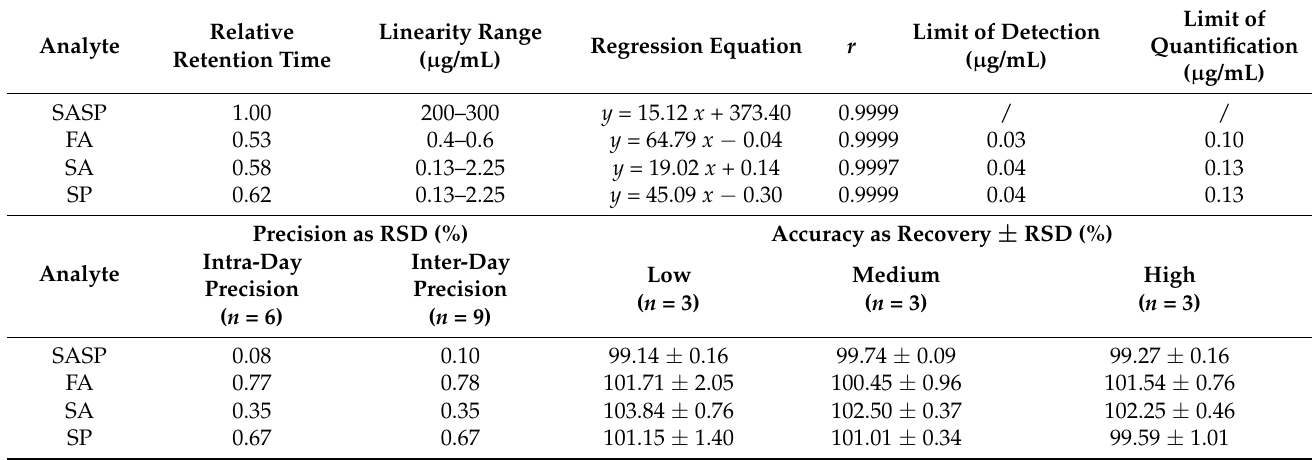
Figure 2. Chromatogram of a working solution showing FA (1), SA (2) and SP (3) at 285 nm (blue line) and SASP (4) at 360 nm (green line). Table 1. Method validation